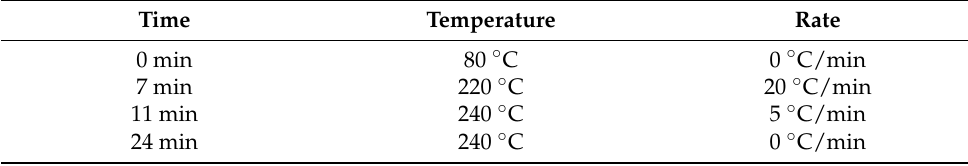
Table 4. Composition of the GC-MS gradient of